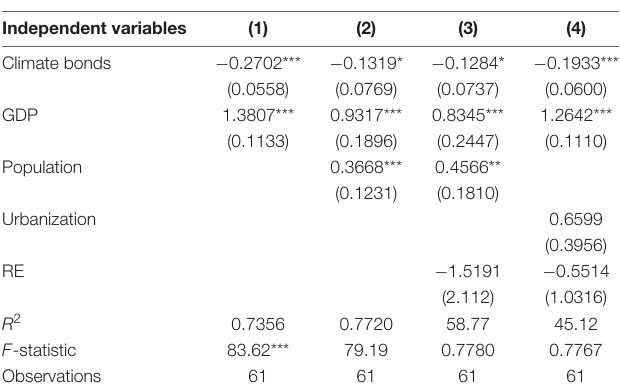
TABLE 4 | Sensitivity